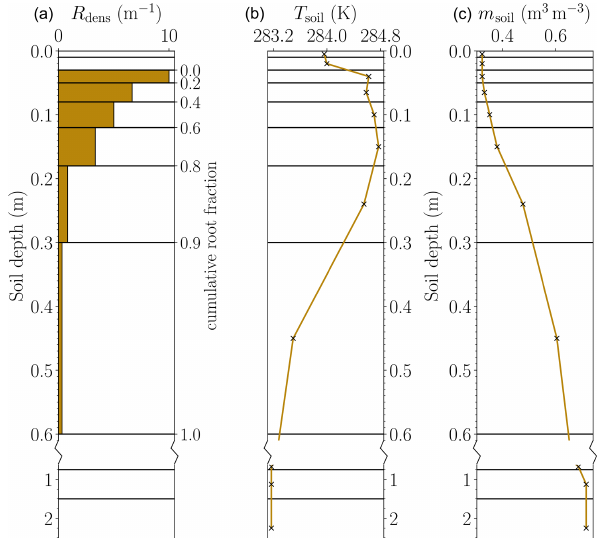
Figure 1. Vertical soil layer setup of root density ( R dens , a ) as well as initial profiles of temperature (b) and moisture (c) . Note the bro- ken vertical axis with a changed linear increment in the deeper lay- ers. The root fraction of each soil layer (see R fr in Table 4) is the difference of the cumulative root fraction (Eq. 34; shown on the vertical axis) between two